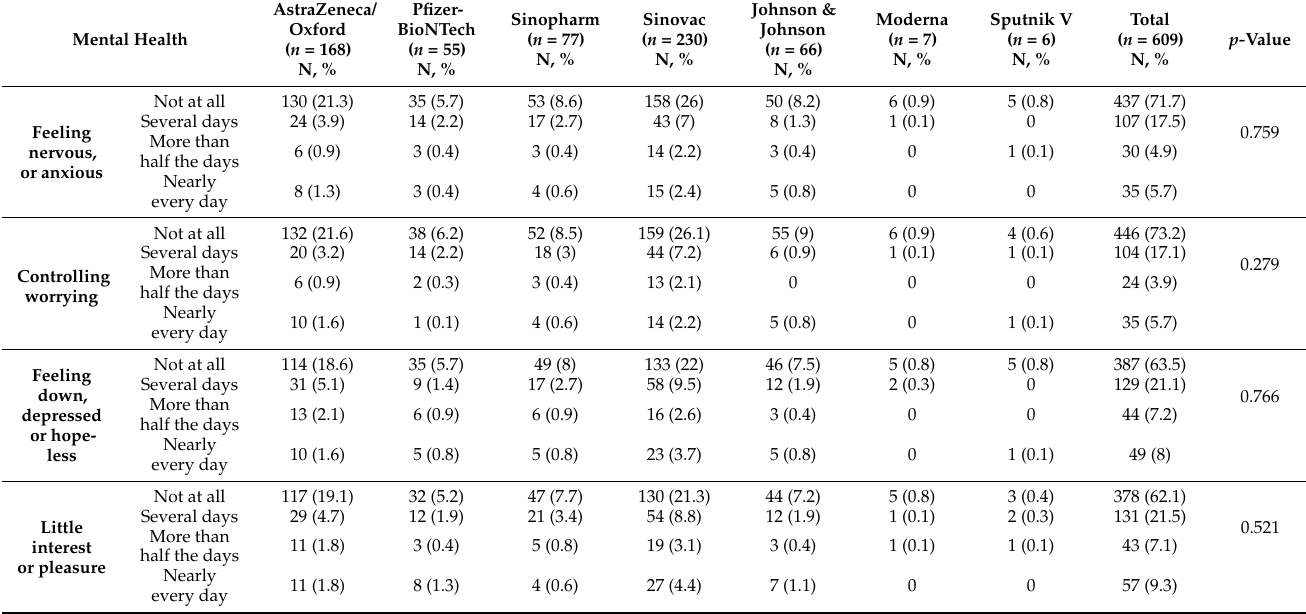
Table 7. Mental health symptoms and association with COVID-19 vaccination receipt among partici- pants ( n =